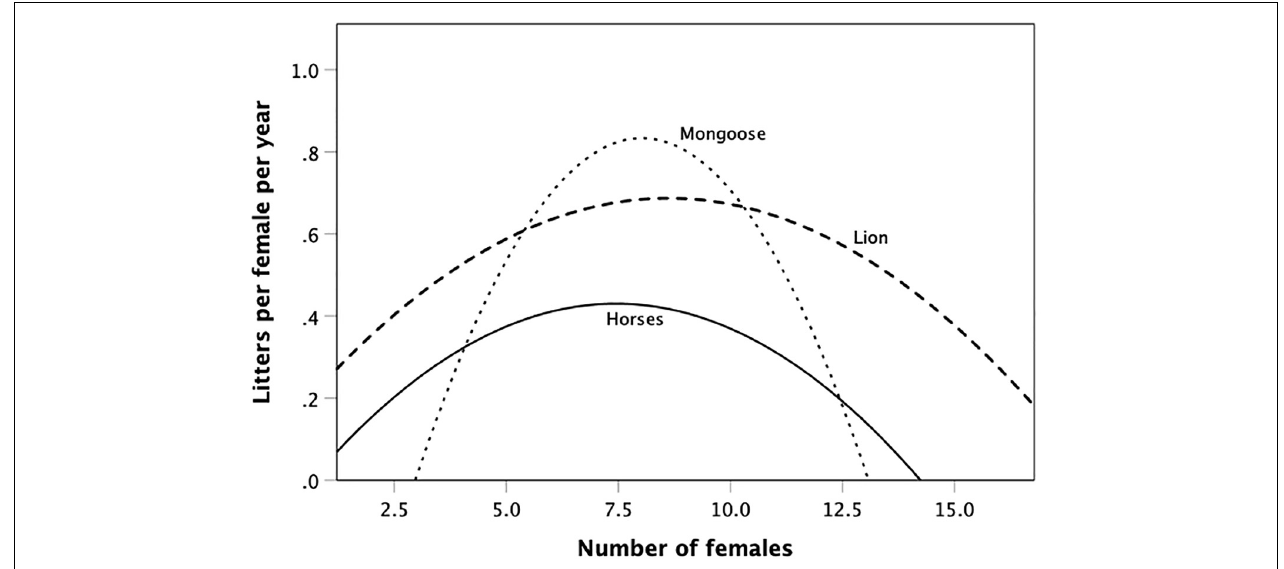
FIGURE 3 | Mean fertility (litters per female per year) for groups of different size for banded mongoose ( Mungos mungo ), averaged across three separate years from the same population (De Luca and Ginsberg, 2001); lion ( Panthera leo ), Serengeti: the plotted curve is the equation given by Mosser and Packer (2009) with territory quality held constant; feral horses ( Equus caballus ), Shackleford Banks, N. Carolina, United States (Rubenstein, 1986). For individual data distributions, see Supplementary Figure 2 . Source: Supplementary Dataset 2 .